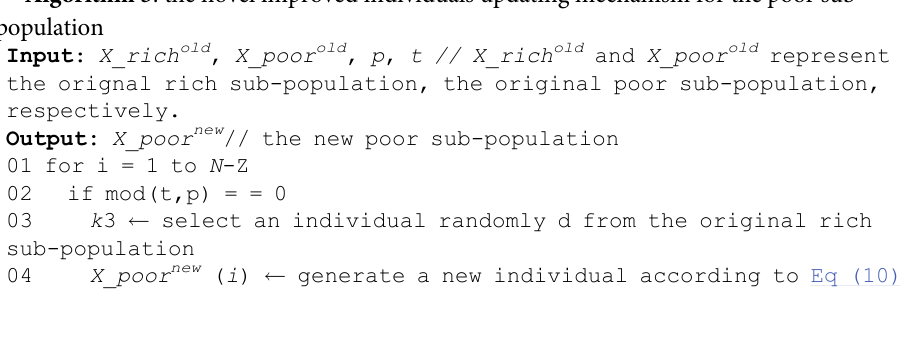
Algorithm 3 : the novel improved individuals updating mechanism for the poor sub-